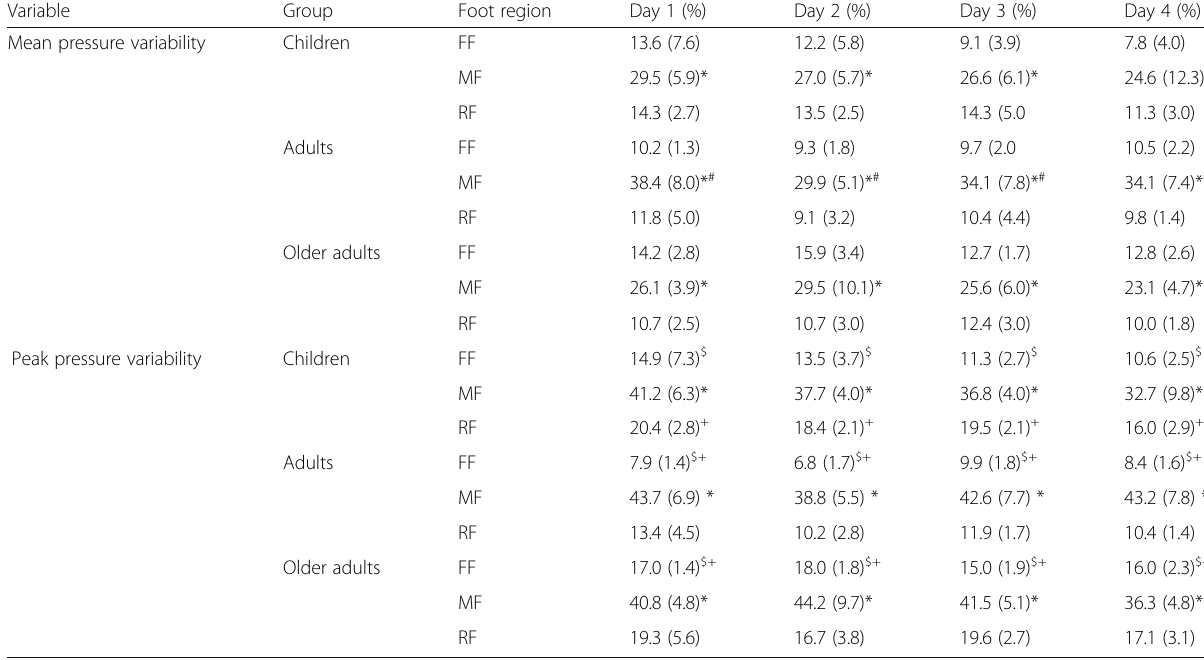
Table 1 Coefficient of variation determined for each day, foot region and group, considering data of mean and peak pressure. Data are expressed in percentage (%) considering mean and standard deviation data from each foot region. FF: forefoot; MF: midfoot; FR: